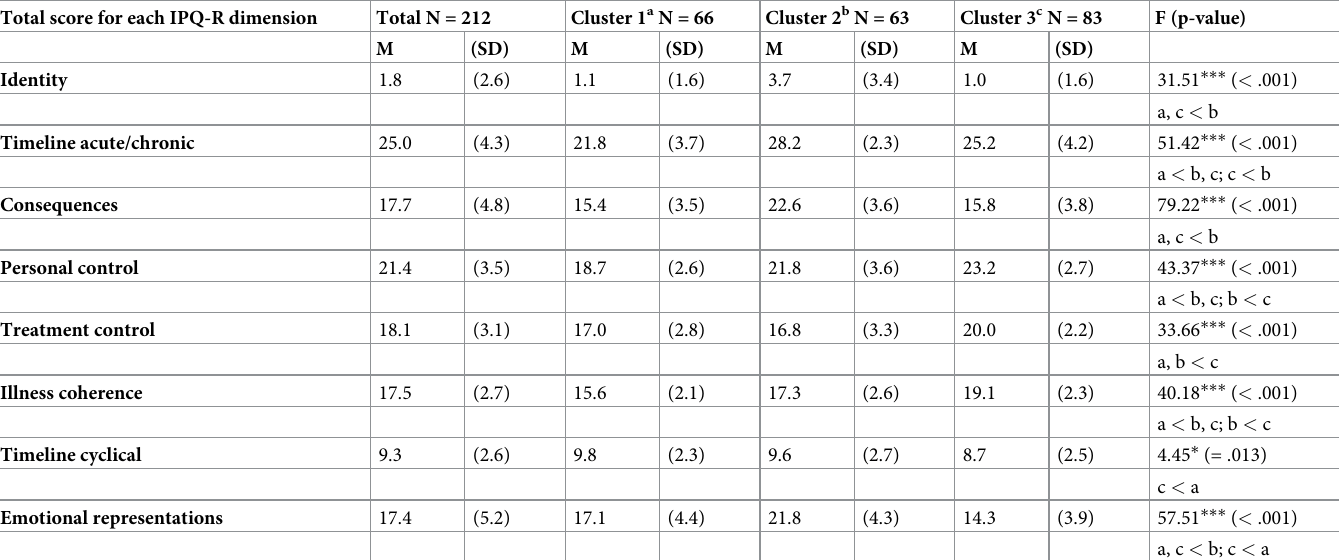
Table 2. Comparison of illness perception among